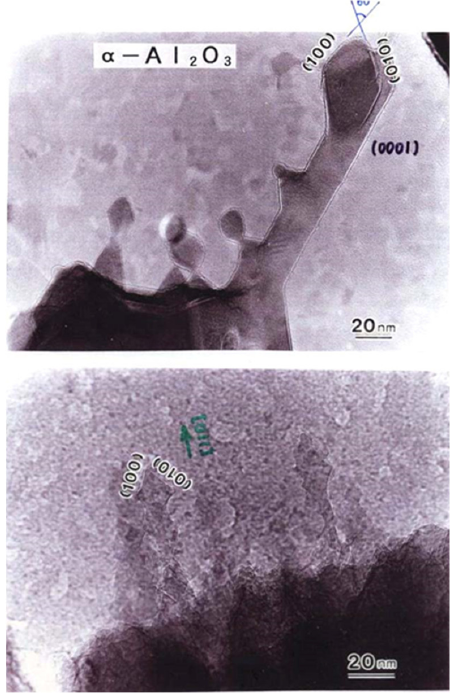
Figure 16. α-Al 2 O 3 rods epitaxially grown from the θ-Al 2 O 3 surface by electron beam irradiation at Figure 16. α -Al 2 O 3 rods epitaxially grown from the θ -Al 2 O 3 surface by electron beam irradiation at 2.1 × 10 20 e/cm 2 sec, as shown in Figure 2. The rods grew in the [110] direction and were faceted by 2.1 × 10 20 e/cm 2 s, as shown in Figure 2. The rods grew in the {110} direction and were faceted by {100} surfaces [3]. {100} surfaces [3].